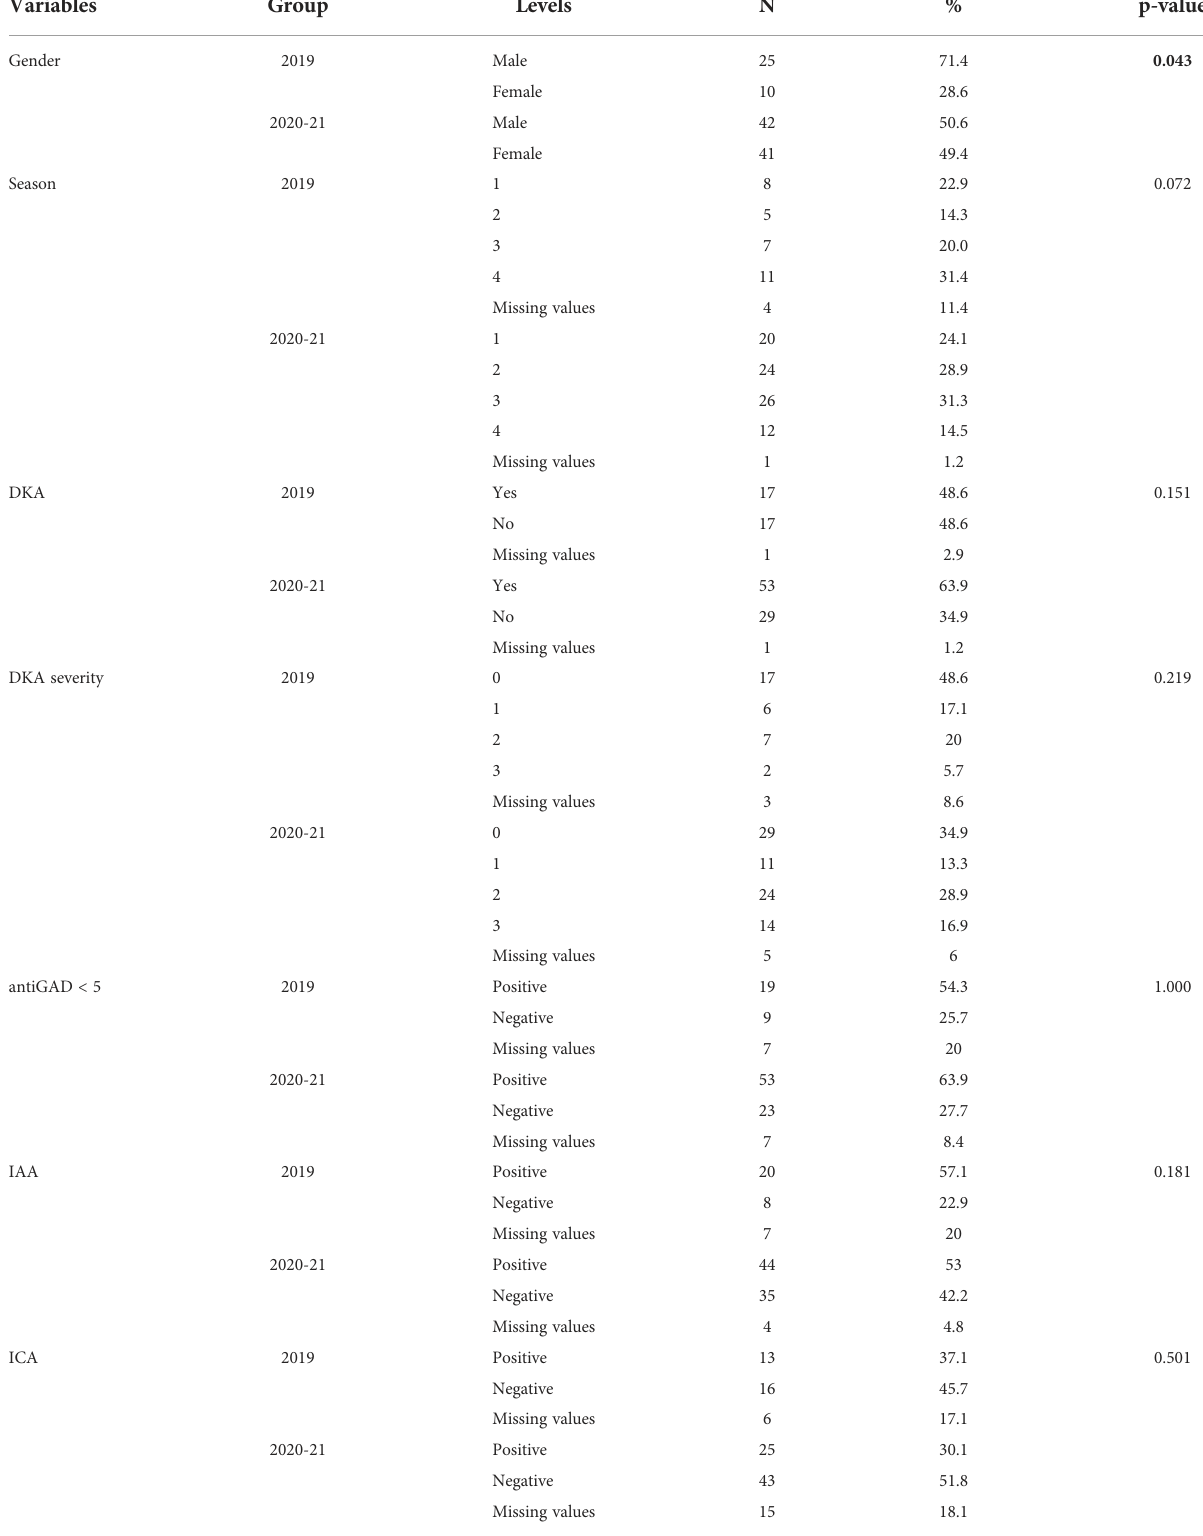
TABLE 1 Demographic and clinical characteristics of children and adolescents admitted with DKA: quantitative variables ( Ν = 118). Variables Group Levels Ν % p-value * Gender